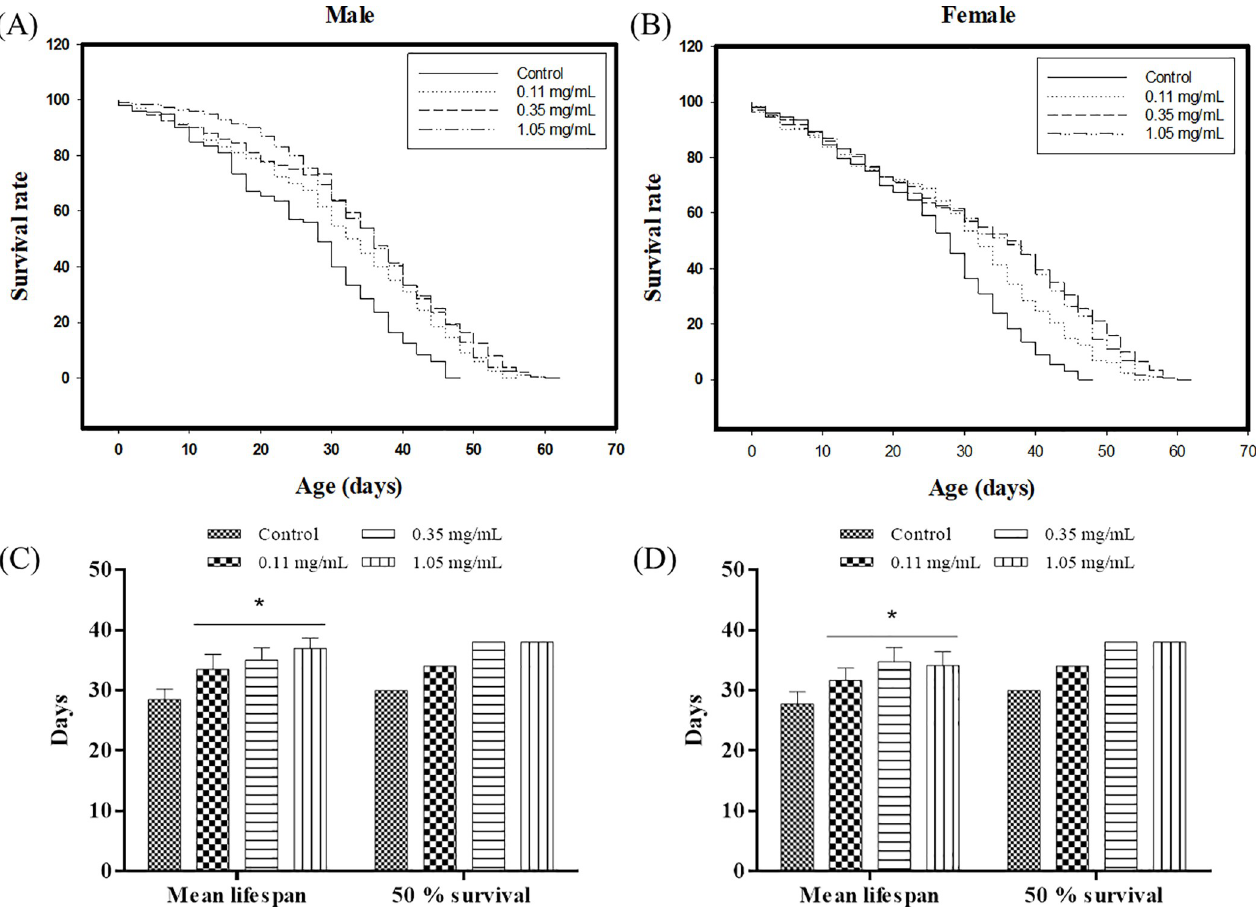
Fig 1. (A, B) Maximum lifespan, (C, D) mean lifespan, and 50% survival time extension by different concentrations of erinacine A-enriched H . erinaceus mycelia in Drosophila (A, C) male and (B, D) female flies (n = 200). � p < 0.05 compared with the control group.